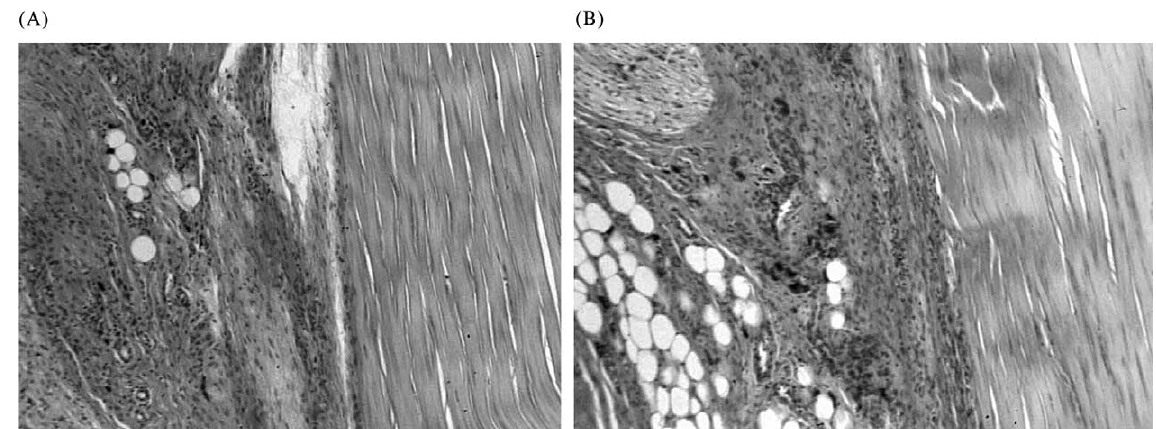
FIG. 6. Five weeks after tendon injury in the L-NAME-treated rat ( (cid:4) / 10, haematoxylin and eosin). Chronic inflammatory response still evident with a persistent accumulation of large macrophages and mast cells. Subcutaneous tissue is infiltrated with large numbers of inflammatory cells (A and B). Tendon is completely adherent to synovium